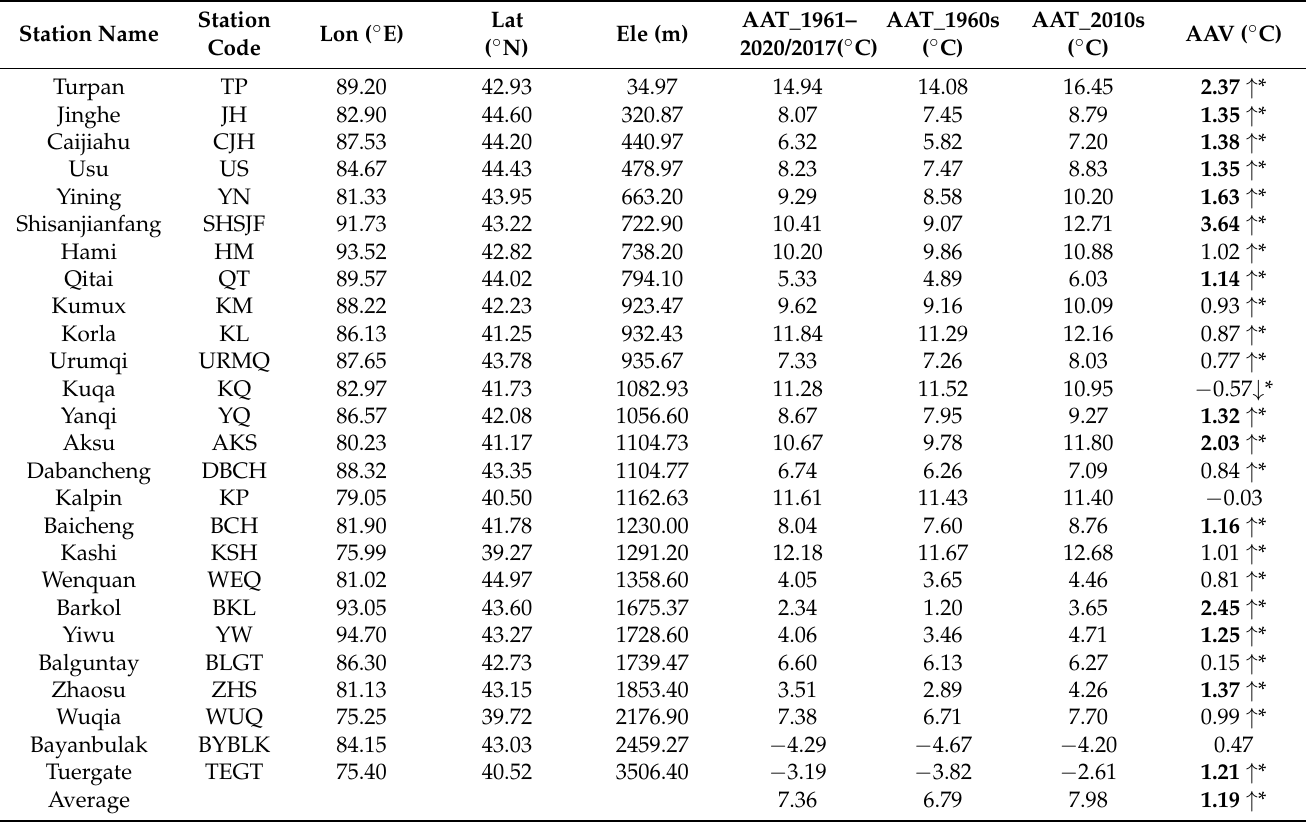
Table 1. Descriptive information of the meteorological stations selected in the